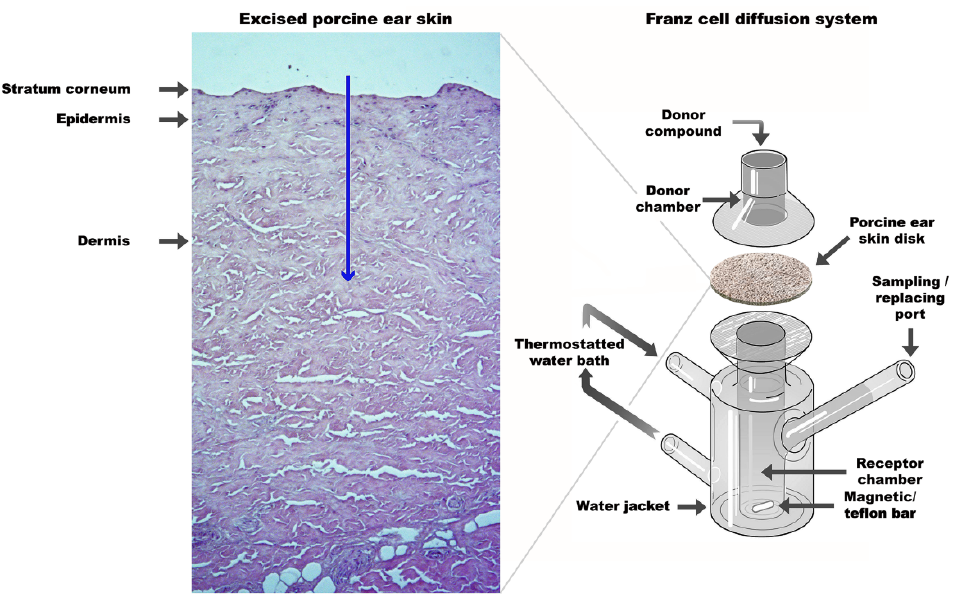
Figure 1. Schematic diagram of the static Franz diffusion cell used in the in vitro permeation tests with CG-DES showing the pathway for drug permeation (blue arrow).